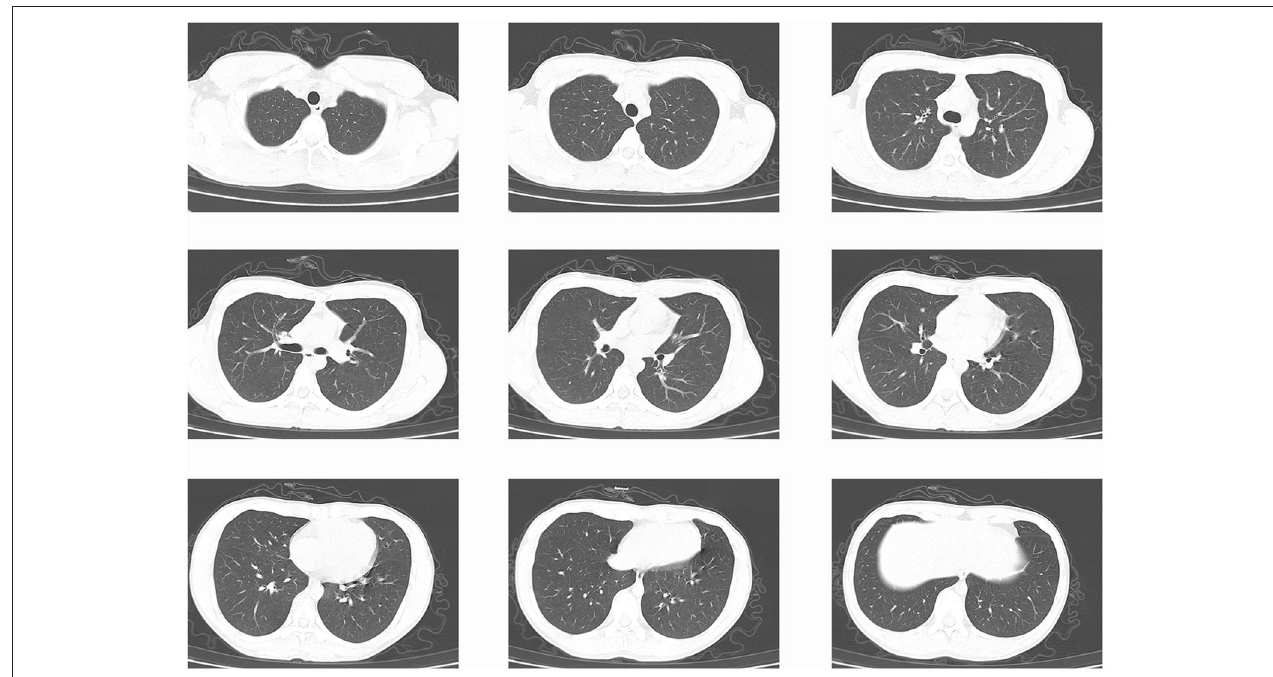
FIGURE 1 | Chest computed tomography (CT) scan of the positive SARS-CoV-2 individual examined on March 13, 2020. The scans show healthy lungs based on the absence of abnormal shadow patch and the presence of ground glass